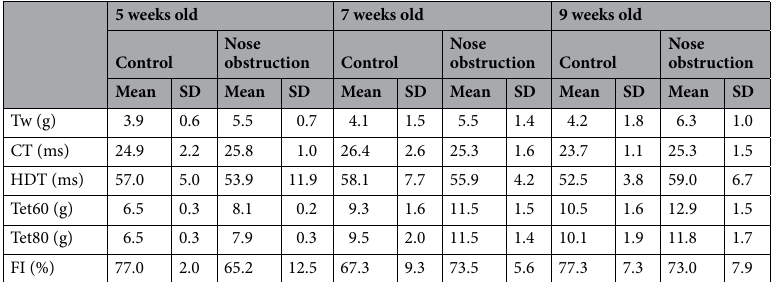
Table 1. Mean values and standard deviation of the contractile properties of the genioglossus muscle. Data presented as mean mean ± standard deviation (SD). Tw twitch force, CT contraction time, HDT half-decay